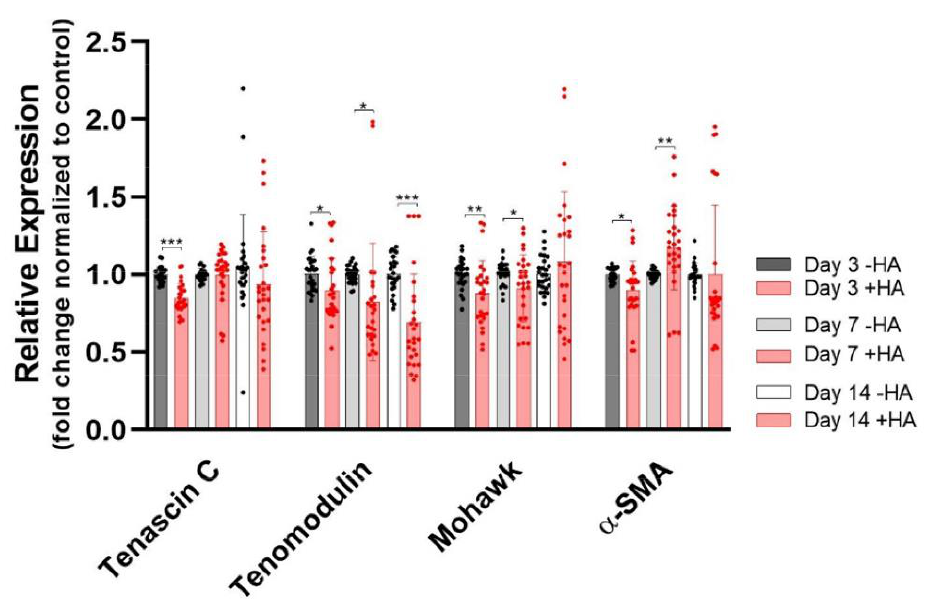
Figure 3. Tendon markers and fibrotic marker α -SMA . Stars indicate pairwise comparison probability in Student’s t test, where HA was compared to the control: p < 0.05 (*), p < 0.01 (**) and p < 0.001 (***).